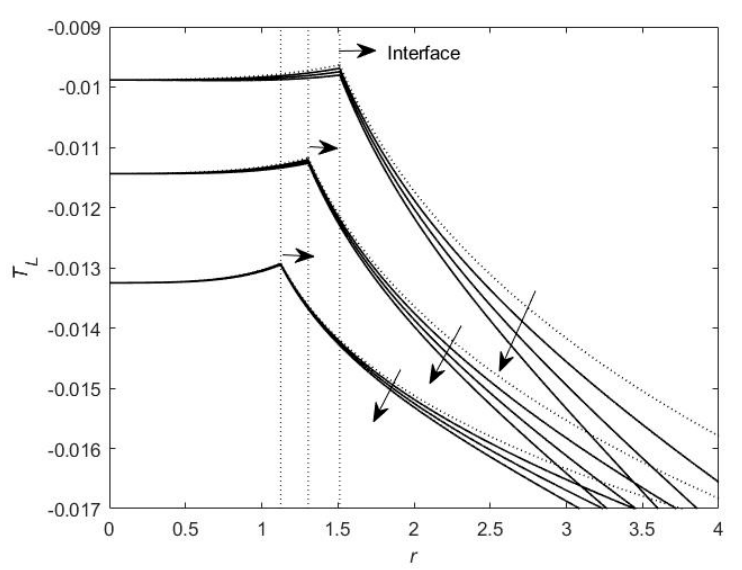
Figure 5. The variations in the interface growth velocity along different directions = / 4 θ π , 5 /12 π , (from bottom to top) for shear rate of the forced flow . By contrast, the dashed line denotes the columnar crys- tal growth velocity without the shear flow.